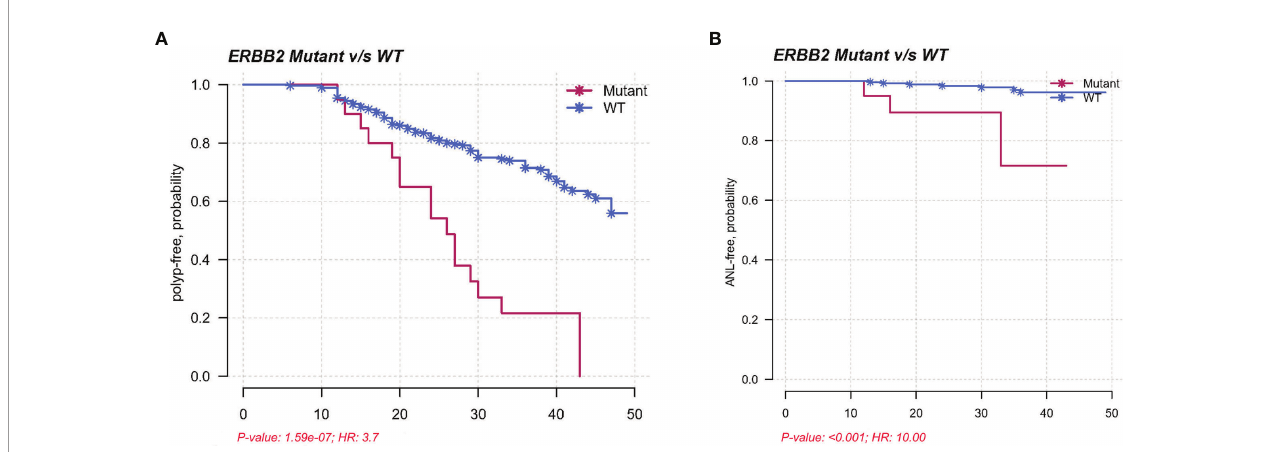
FIGURE 5 | (A) Kaplan – Meier plot demonstrating a shorter polyp-free duration in the ERBB2 mutants than in the wild types in a validation cohort, with a median interval of 26 months compared to 32 months (P < 0.001; HR = 3.7; 95% CI = 2.3 – 6.0). (B) Kaplan – Meier plot showing reduced ANL-free intervals in ERBB2 - mutated SPs in a validation cohort (P < 0.001; HR = 10.0; 95% CI = 2.7 –